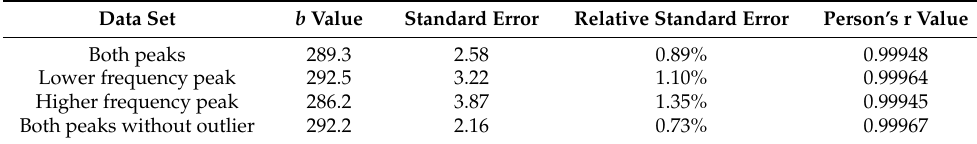
Table 1. Statistical parameters for the linear fit of the different data sets displayed in Figure